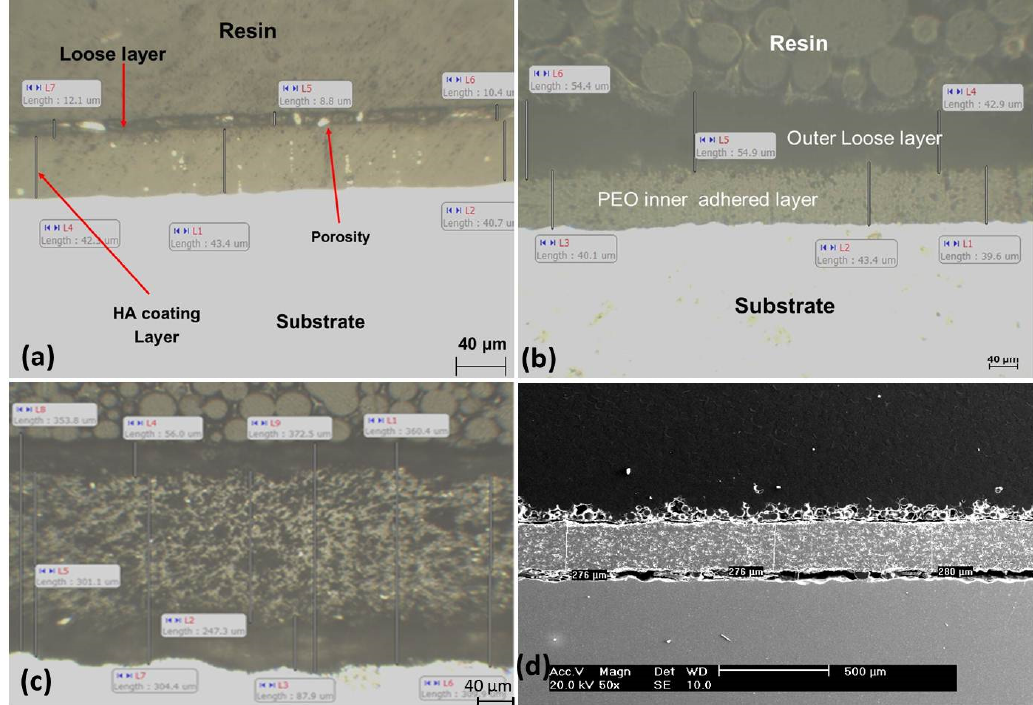
Figure 3. Optical cross-sectional micrographs of coating layers after polarization tests for ( a ) Hard Anodizing (HA), ( b ) Plasma Electrolytic Oxidation (PEO), ( c ) Plasma Spray Ceramic (PSC) and ( d ) SEM image of